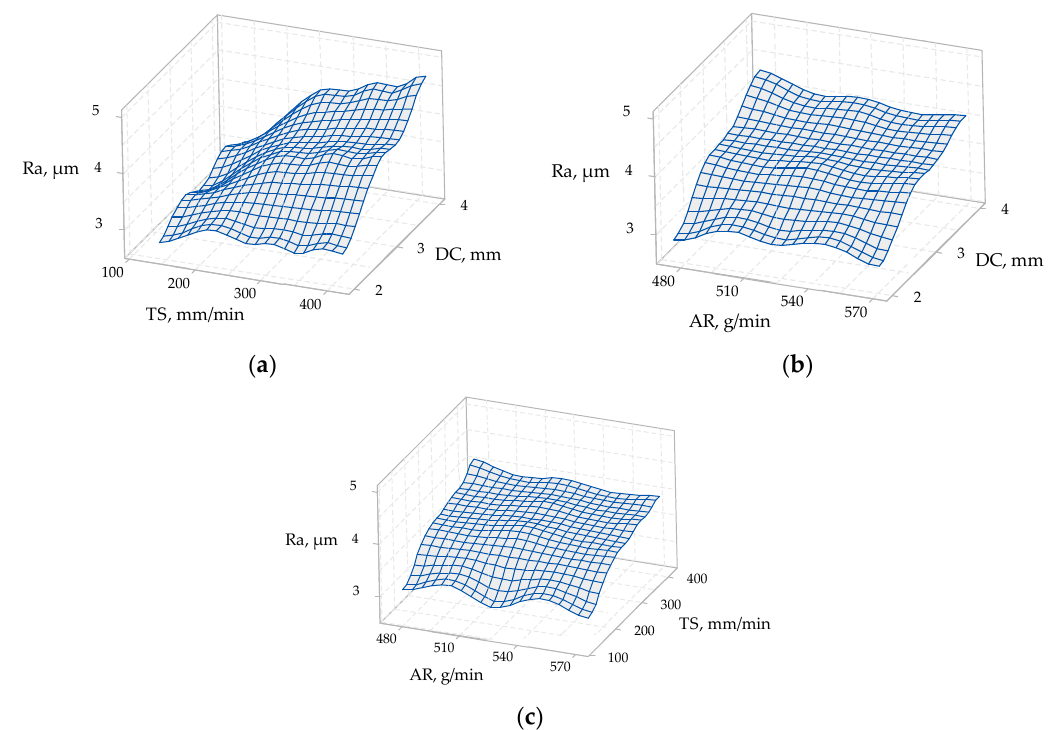
Figure 7. 3D surface plots of process parameters vs. surface roughness of 5 mm material thickness: ( a ) traverse speed (TS) vs. depth of cut (DC) on surface roughness ( Ra ); ( b ) abrasive mass flow rate (AR) vs. depth of cut (DC) on surface roughness ( Ra ); ( c ) abrasive mass flow rate (AR) vs. traverse speed (TS) on surface roughness ( Ra ). Table 7. ANOVA results for the 5 mm material thickness.